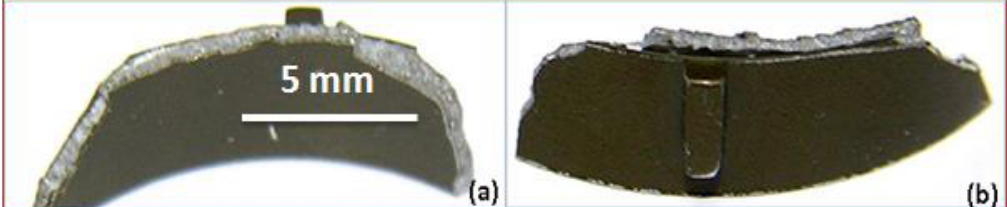
Figure 3: Photographs of the as-received fractured metal piece of connector 1 in different views